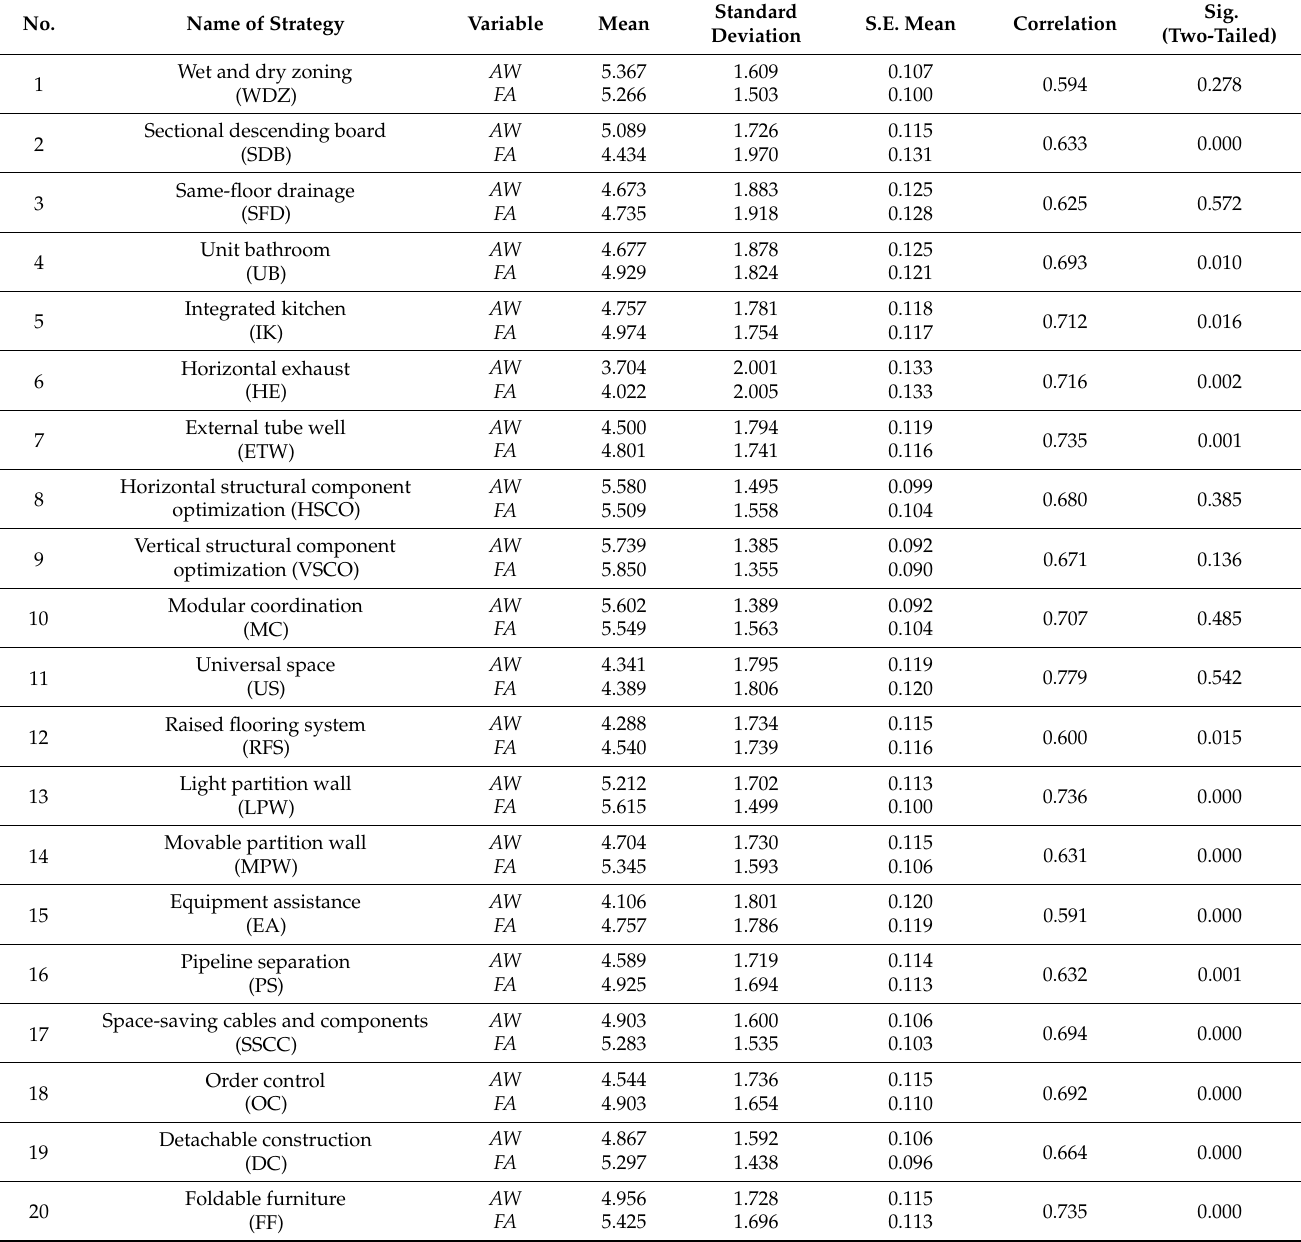
Table 6. Statistics for the evaluation of each